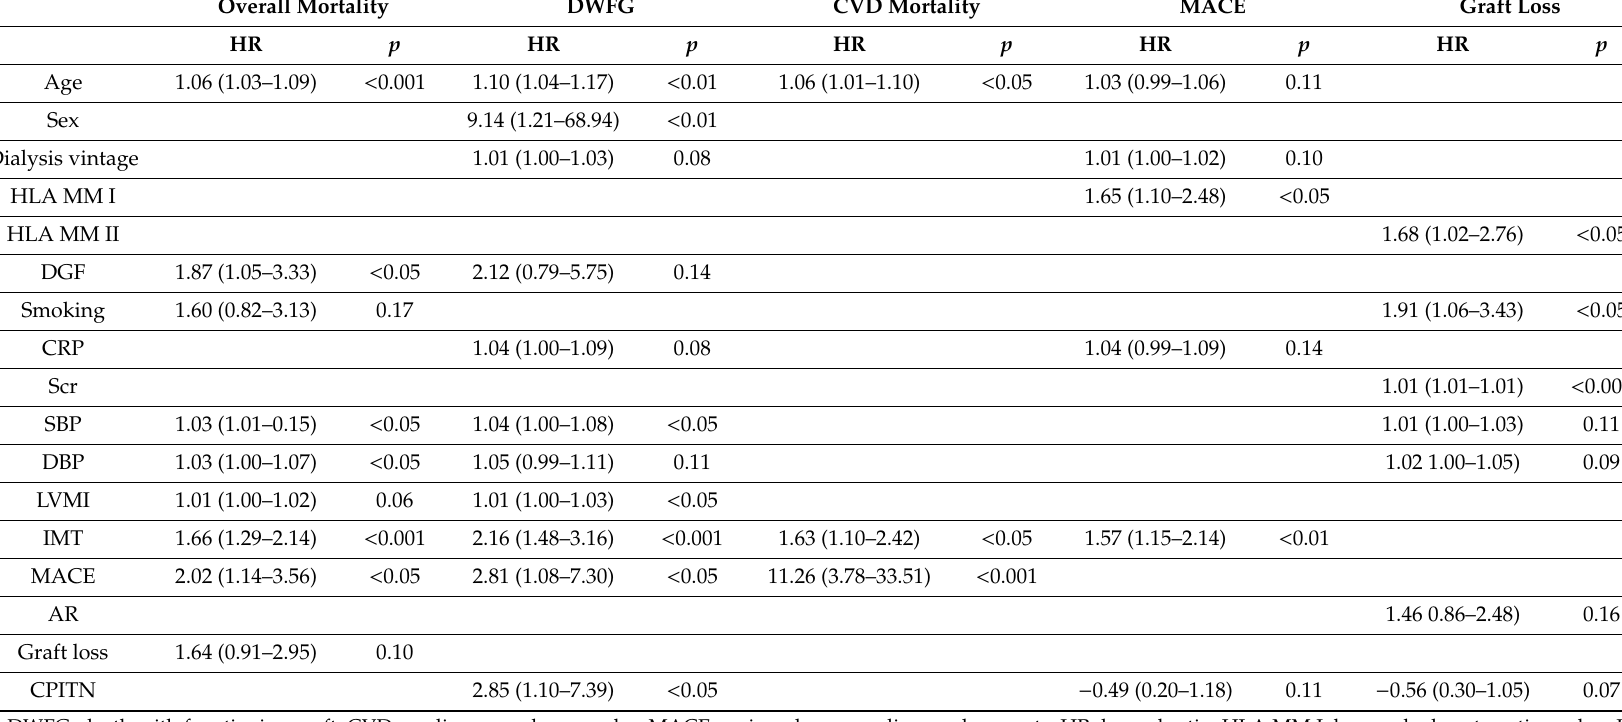
Table 3. Results of univariate